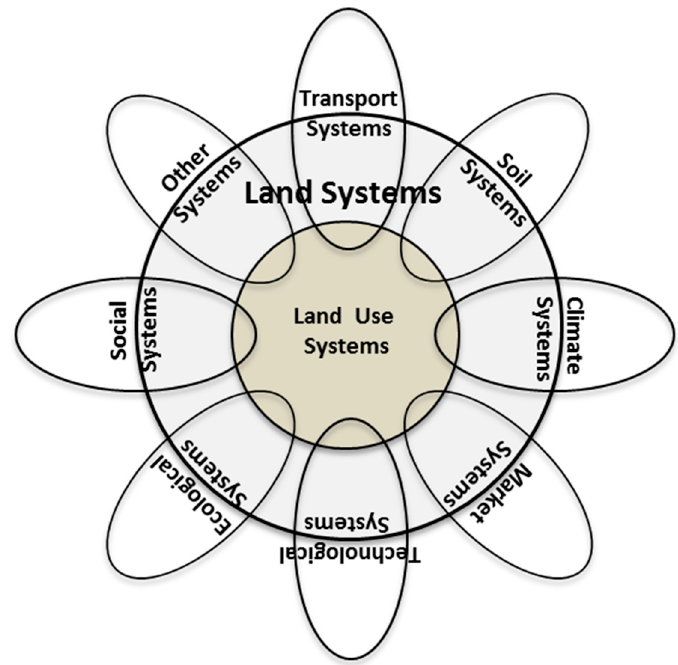
Figure 1. Land systems. At the centre of a land system is the land use system. Interacting with the land use system are the related systems: their dynamics are strongly coupled with dynamics in the land use system. Land systems encompass the land use system and parts of these related systems. These related systems can interact with each other, and may overlap (for simplicity, not reflected here). A feedback within a land system is a situation in which the land use system and a related system are connected together in such a way that they influence each other and their dynamics are thus strongly coupled (based on Aström and Murray [6]).